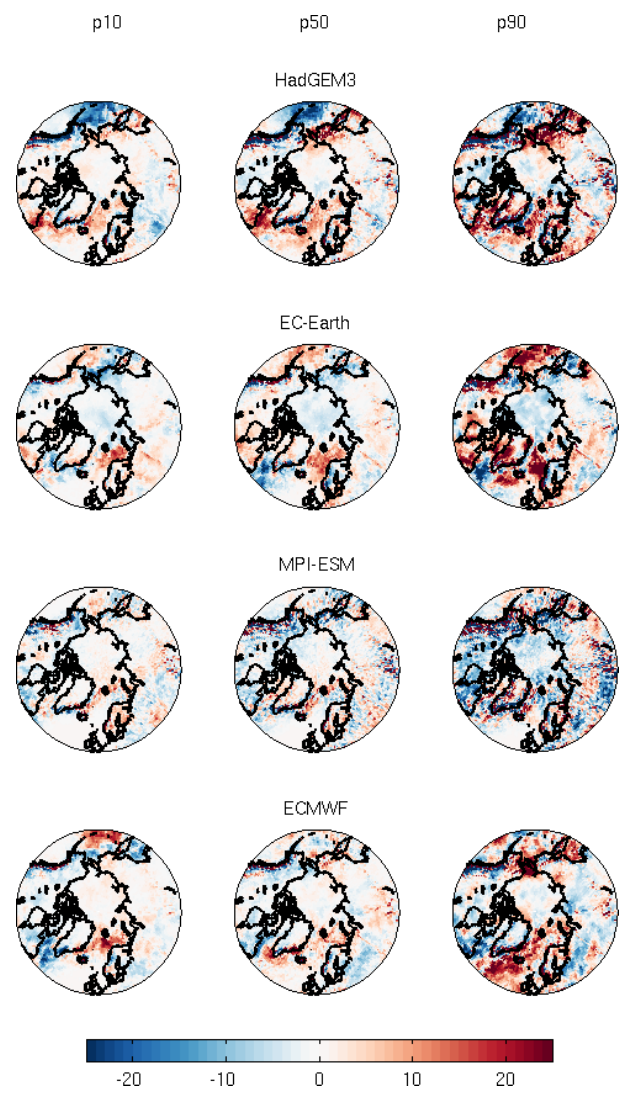
Figure 4. The differences between Hi-res and Std-res model- simulated snowfall (Hi-res minus Std-res) for the DJF months for the 10th (left column), 50th (center) and 90th percentiles (right col- umn).